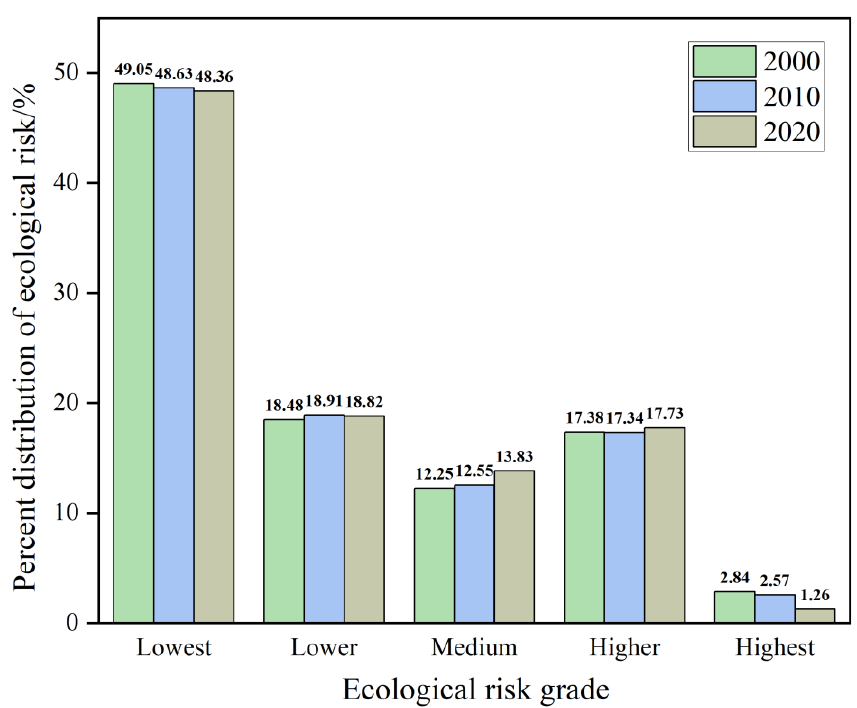
Figure 5. Percentage of land mass at each level of landscape ecological risk in Guilin.